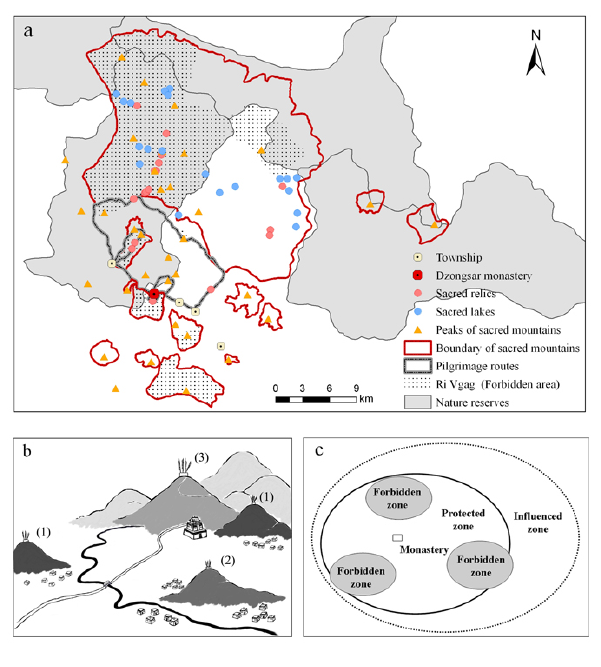
Fig. 2. Spatial distribution of Tibetan sacred sites (a) Sacred sites and four nature reserves around Dzongsar monastery in Ganzi Prefecture, Sichuan Province, China. (b) Spatial distribution pattern of sacred mountains around the monastery: (1) sacred mountains worshipped by single village; (2) sacred mountains shared by multiple villages; (3) sacred mountains of higher hierarchical level in the district accompanied by the monastery. ((c) The zoning pattern of a traditional Tibetan community.